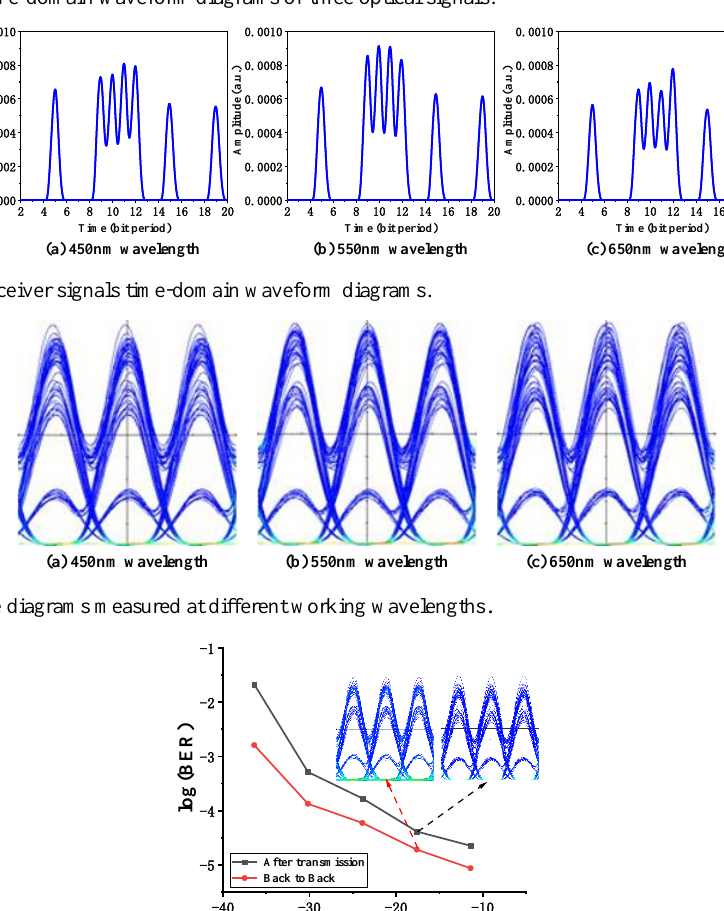
Fig. 2. Time-domain waveform diagrams of three optical signals.